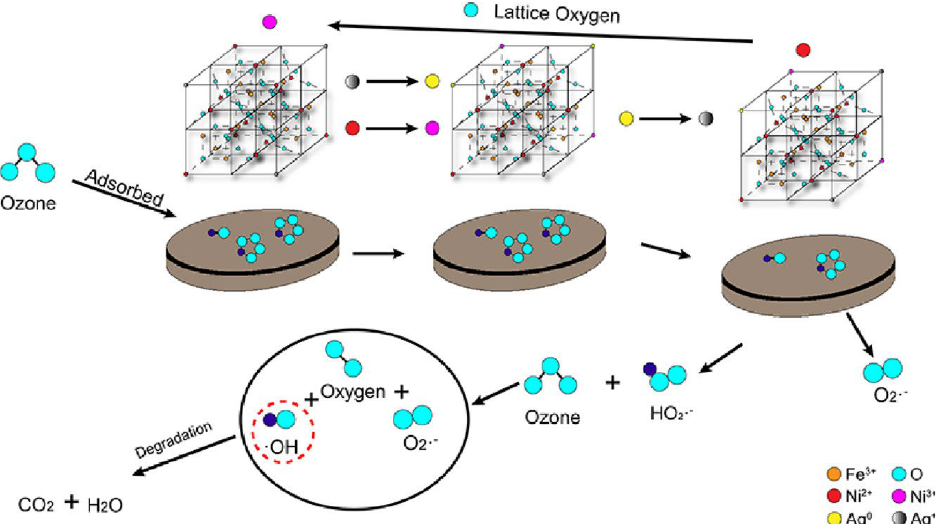
Figure 7. Degradation mechanism of catalytic ozonation for papermaking wastewater by Ag-doped NiFe 2 O 4 . Reproduced with permission from Ref. [89].